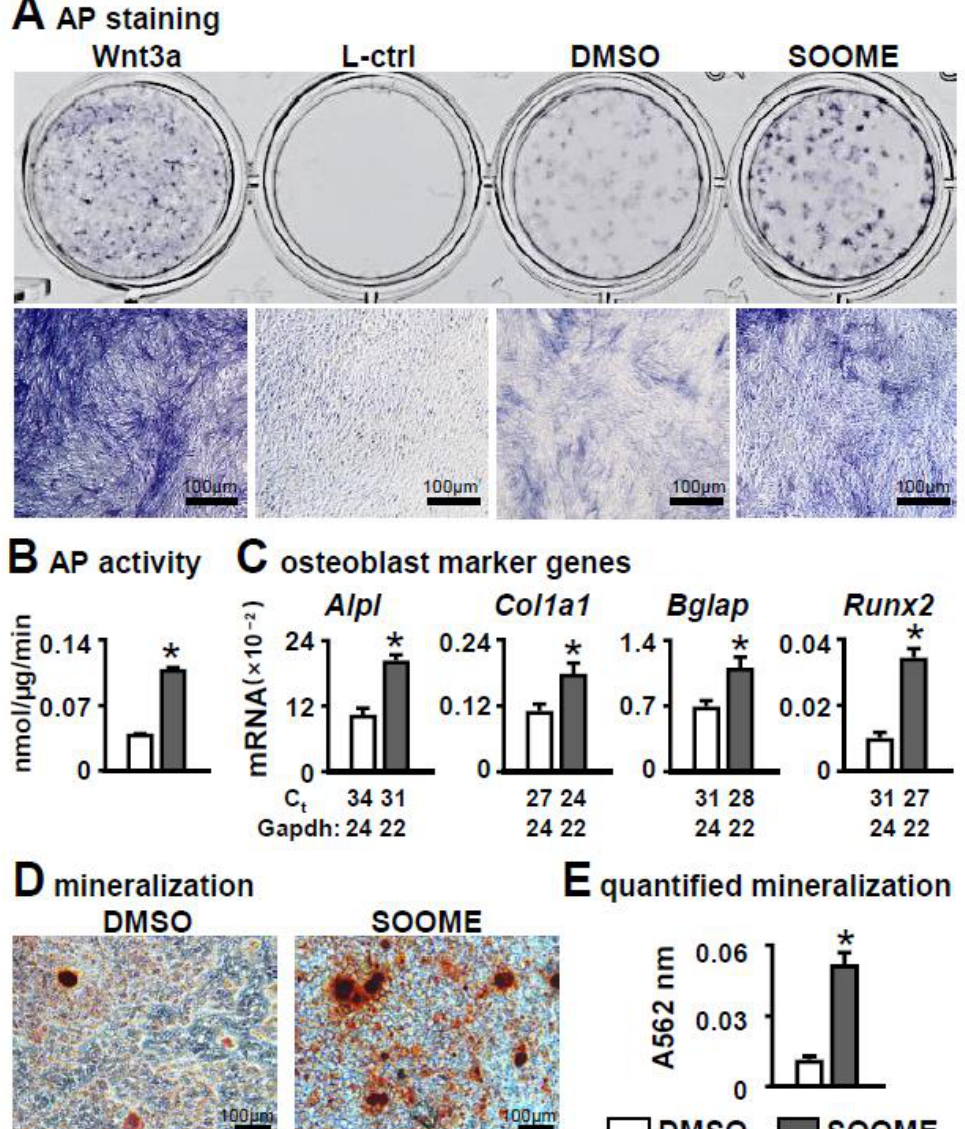
Figure 2. Effects of Wnt signaling-activated osteocytes on osteogenic differentiation in stromal cells. MLO-Y4 was treated with 60 µm S24 for 24 h, then co-cultured with ST2 cells for 3 days, and osteogenic differentiation was evaluated by AP staining ( A ). Wnt3a conditioned medium and its L control medium were used as positive and negative controls, respectively. Lower images are enlargements of upper images; scale bar = 100 µm. ( B ) AP biochemical activity assay. ( C ) Expression of osteoblast marker genes as measured by qPCR. The * symbol indicates p < 0.05 by Student t -test; n = 3. ( D,E ) Mineralization assay of ST2 cells co-cultured with SOOME in growth medium for 3 days and in osteogenic medium for another 14 days. The osteogenic medium was changed every three days. The mineralized bone nodules were photographed after alizarin red S staining, followed by quantification assay. The * symbol indicates p < 0.05 versus DMSO group by t -test; n = 3. Scale bar = 100 µm. Ct, cycle number detected by qPCR machine for a relative amount of target genes .